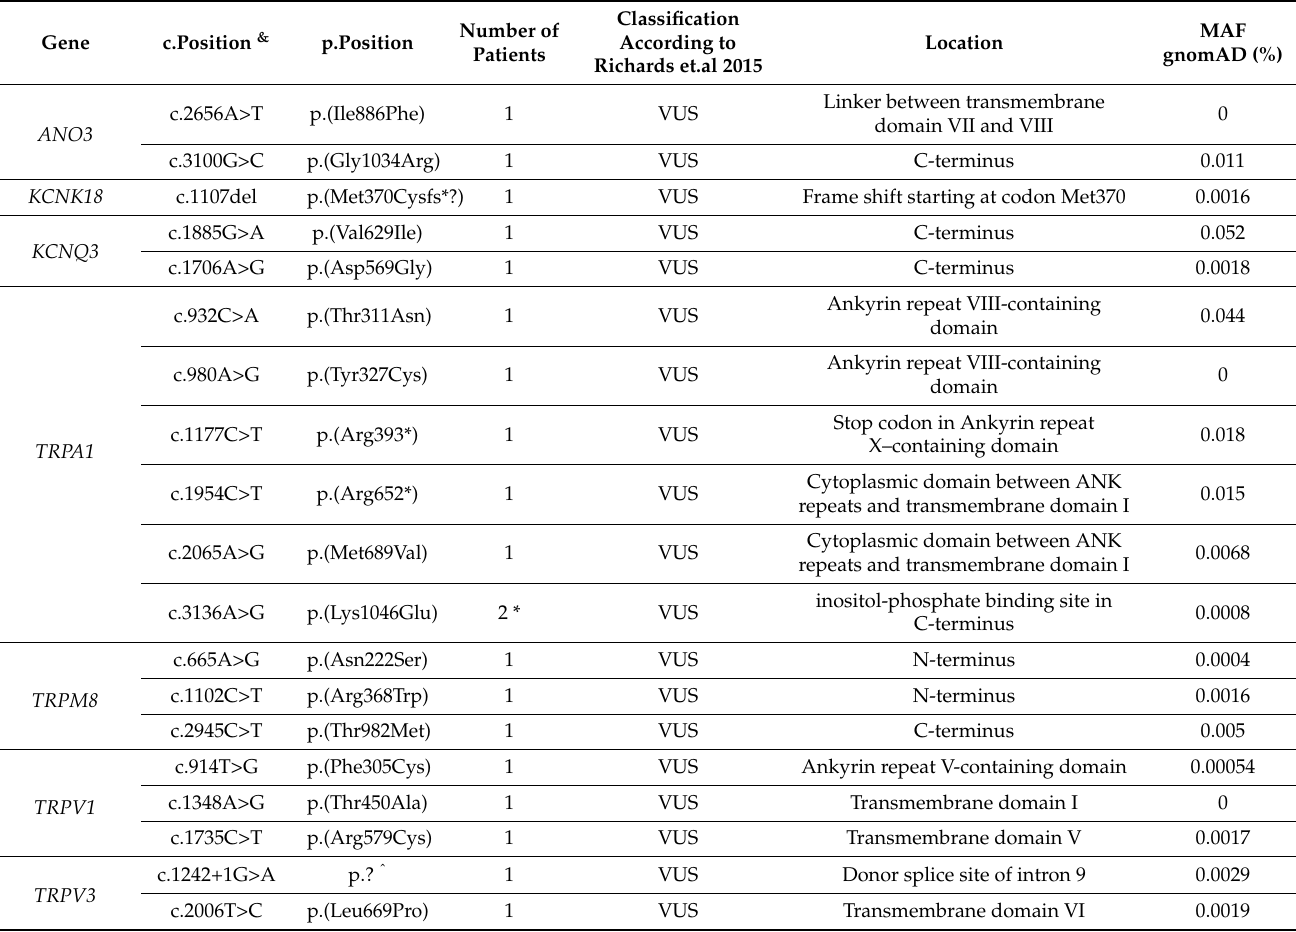
Table 1. Potentially pathogenic variants of ion channel genes identified in patients with SFN (n =